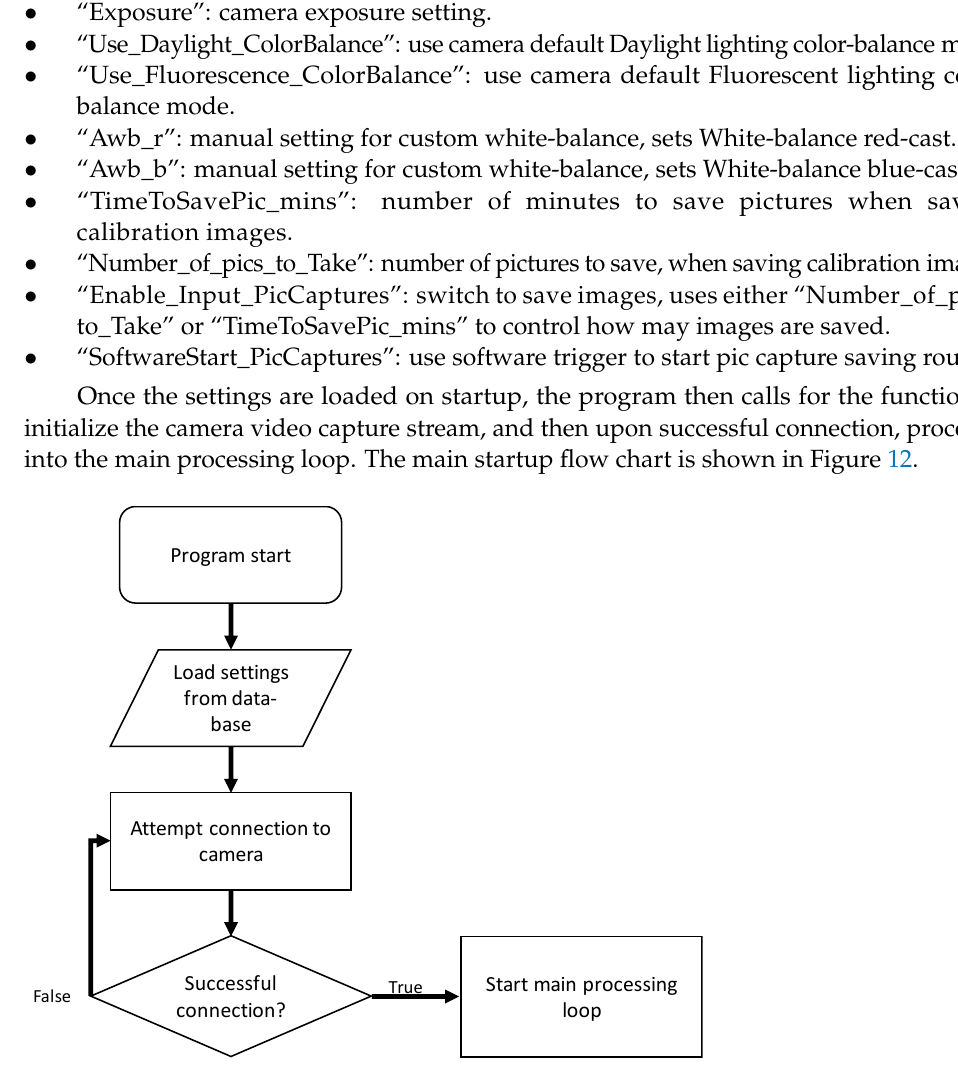
Figure 12. The flow chart for the program initialization that runs on the program start. The IP addresses of the cameras are stored locally in a text file. If the program can connect to the camera, the program will allow image capture from that camera during the main process loop (camera